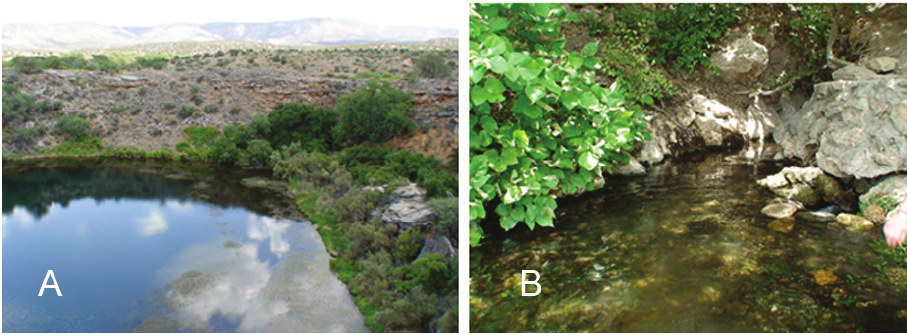
Figure 1. Location of Helobdella blinni sp. n. A The northeast side of Montezuma Well; and B The swallet where the leeches were